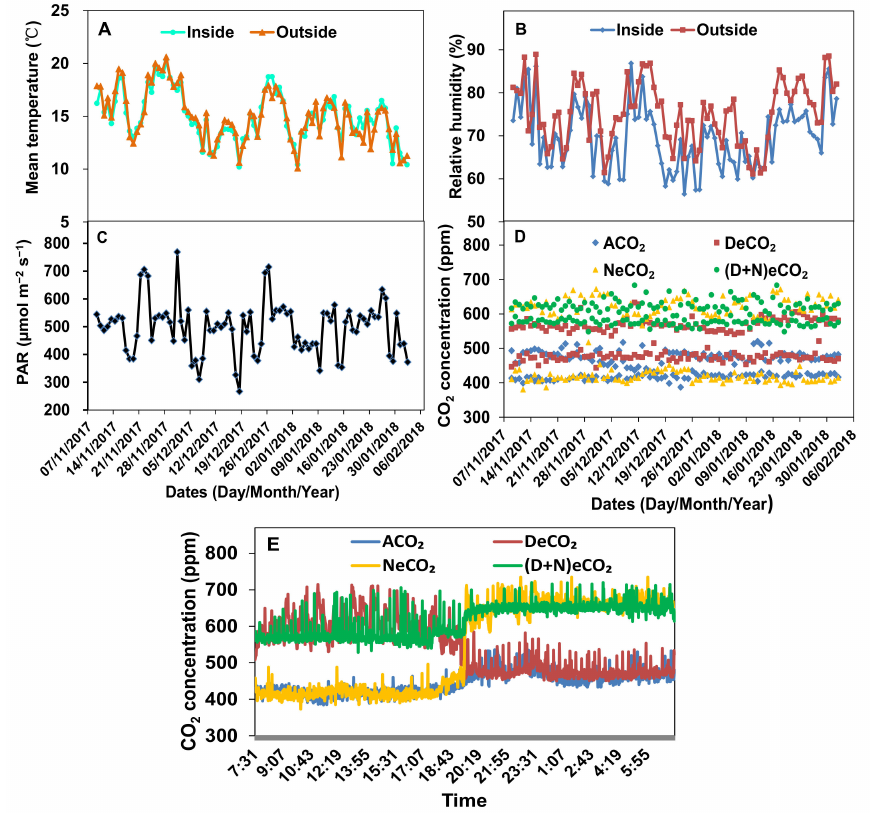
Figure 2. Mean temperature ( A ), relative humidity ( B ), photosynthetic active radiation (PAR, ( C )) and CO 2 concentration ( D , E ) over the experimental period in the growth chambers. ACO 2 : ambient CO 2 , DeCO 2 : elevated CO 2 concentrations at daytime, NeCO 2 : elevated CO 2 concentrations at nighttime, (D + N)eCO 2 : elevated CO 2 concentrations at both daytime and